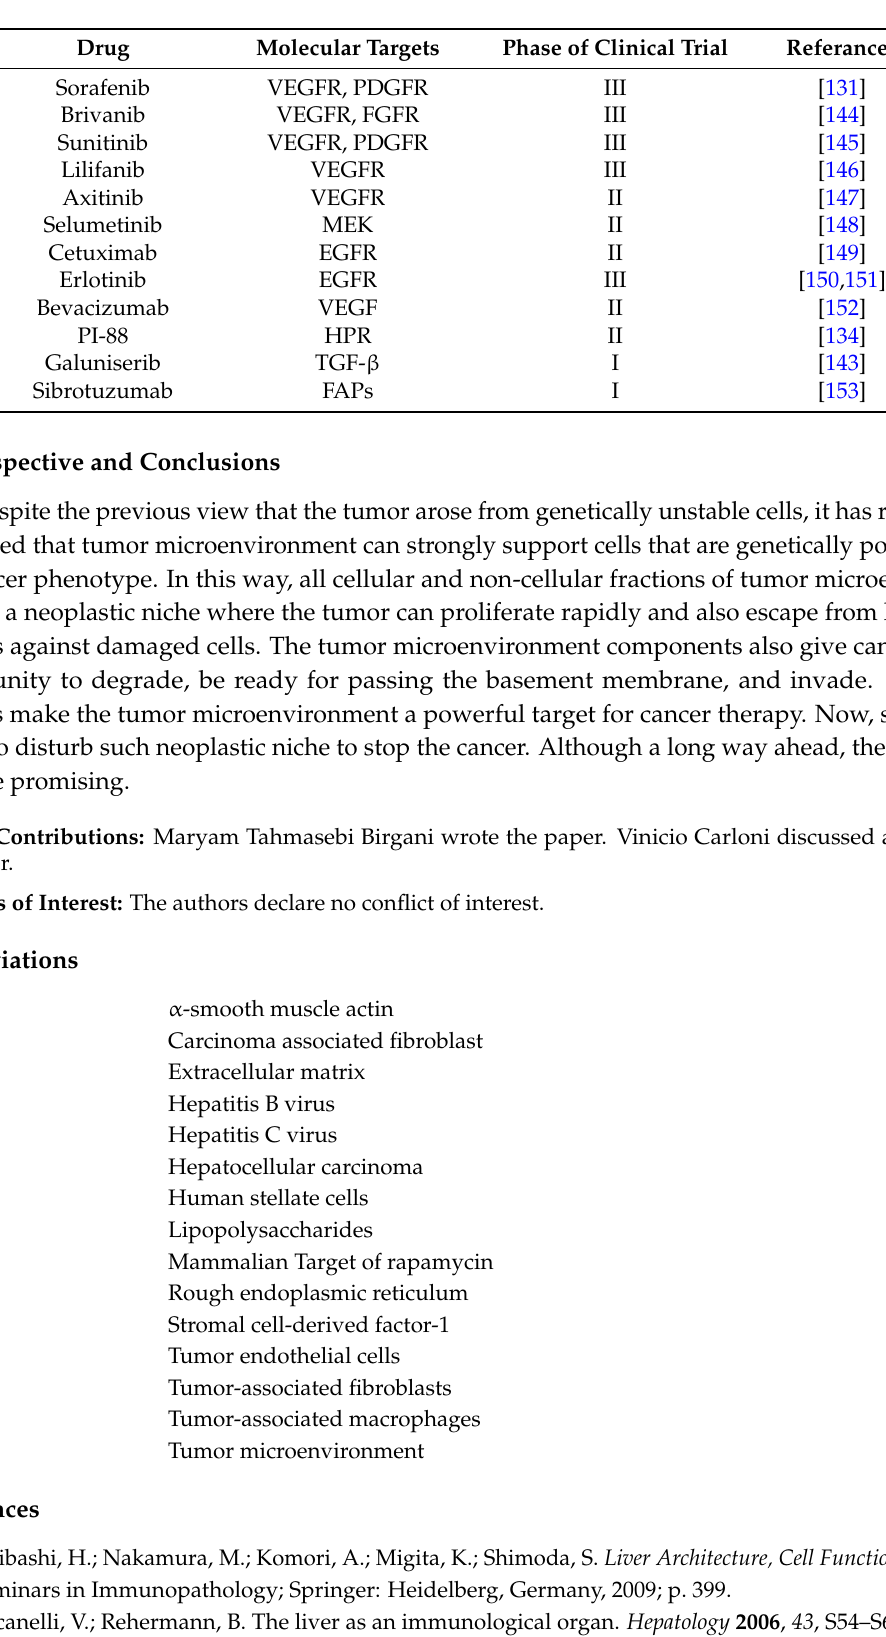
Table 1. TEM-based drugs in clinical trials for HCC